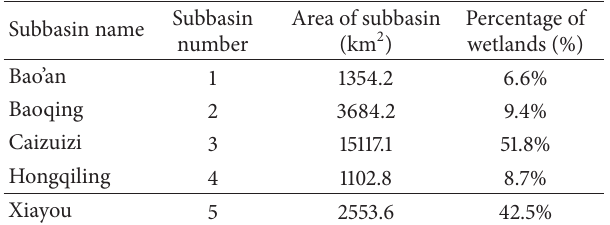
Table 2: Percentage of wetlands in each subbasin in